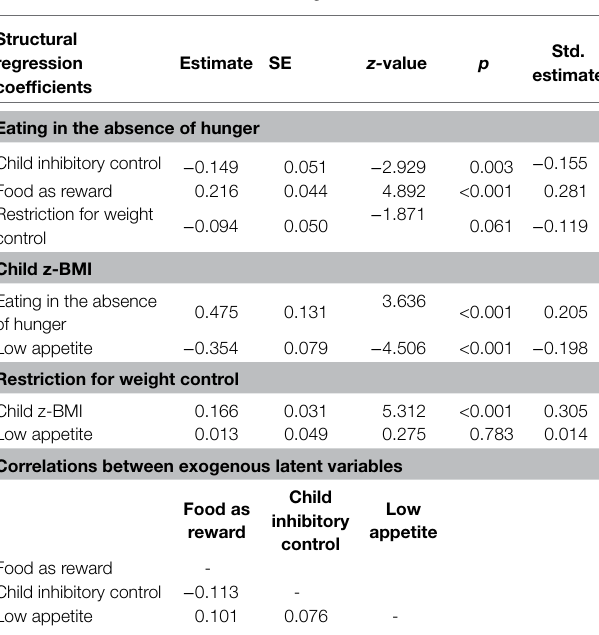
TABLE 5 | SEM model 1B: parameter estimates, SE, z -values, value of p , and standardized estimates (i.e., completely standardized solutions) for regression parameters, and correlations between exogenous latent